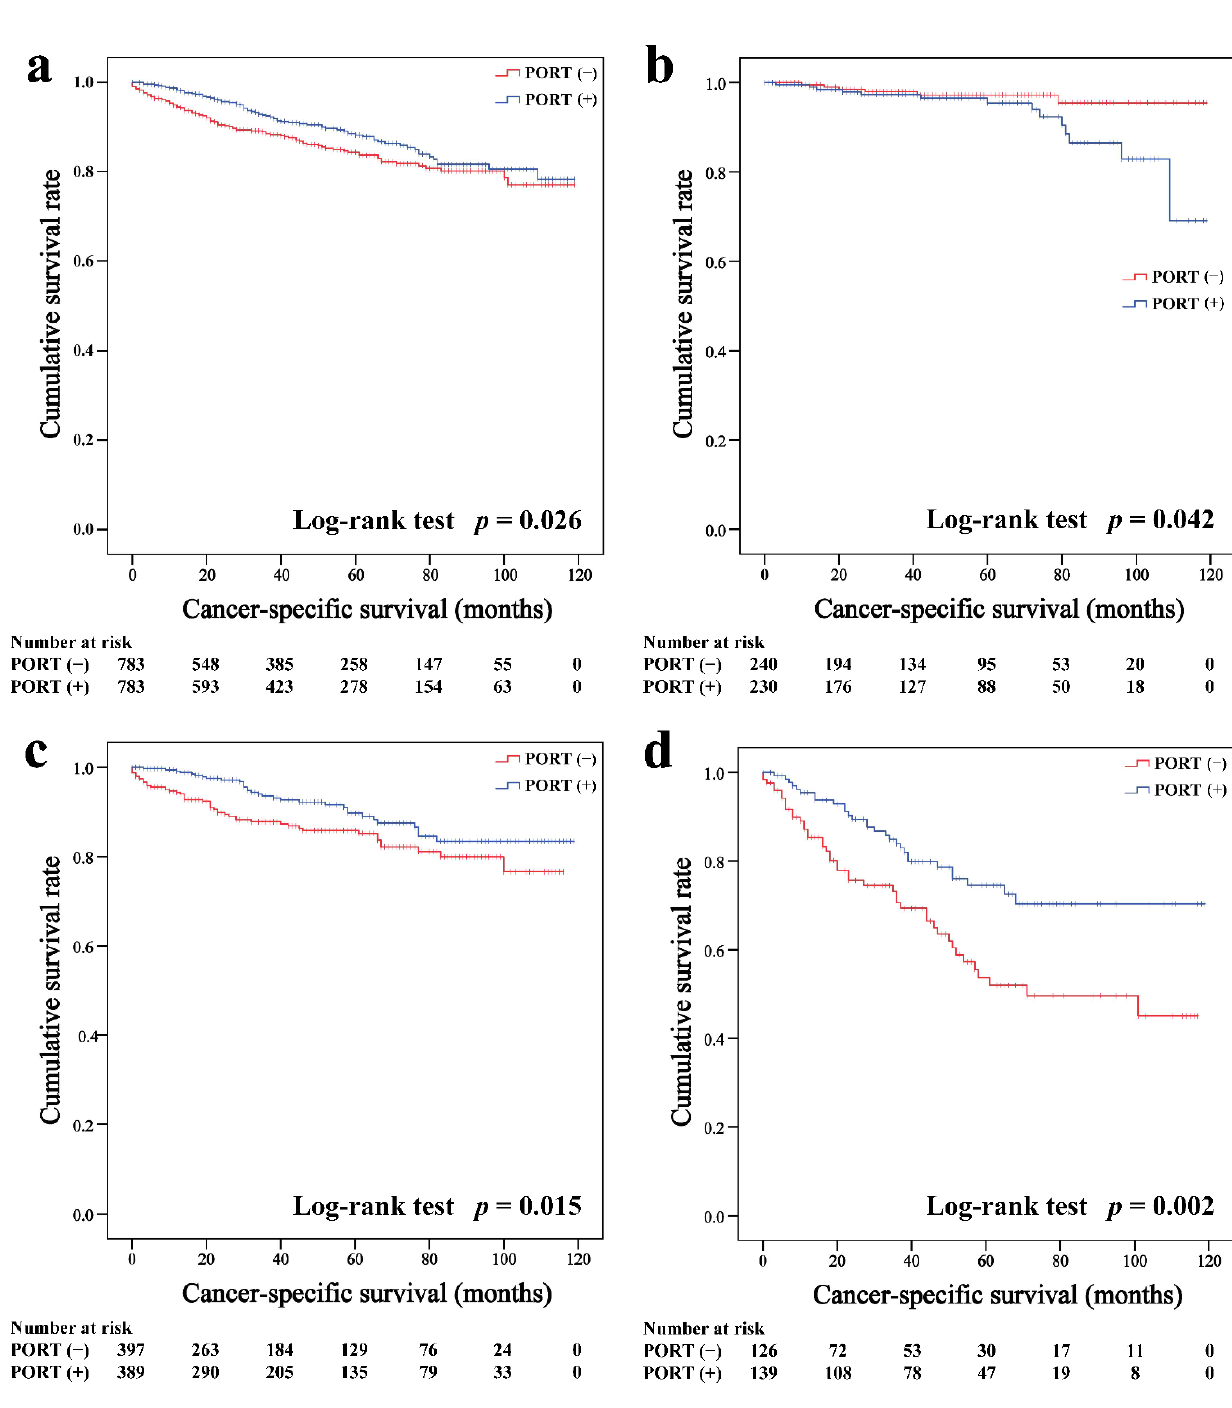
Figure 3. Cancer-specific survival in all ( a ), Masaoka-Koga stage I–IIA ( b ), IIB ( c ), and III–IV ( d ) thymoma patients.